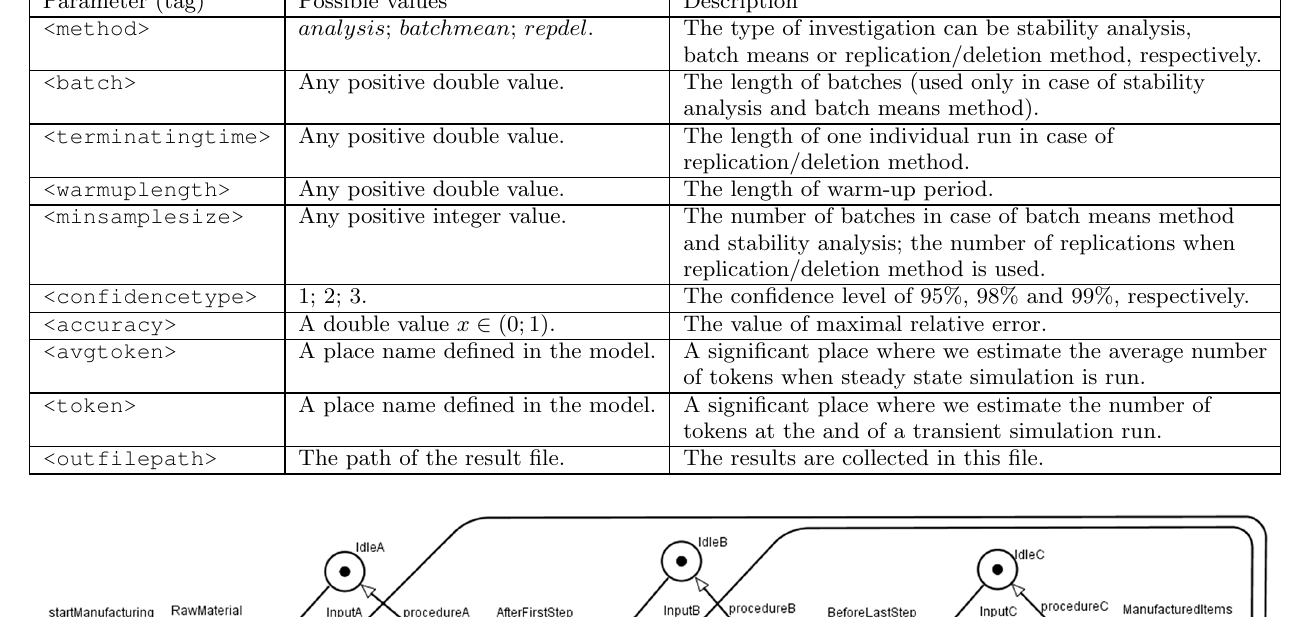
Table 1: Overview of system parameters.